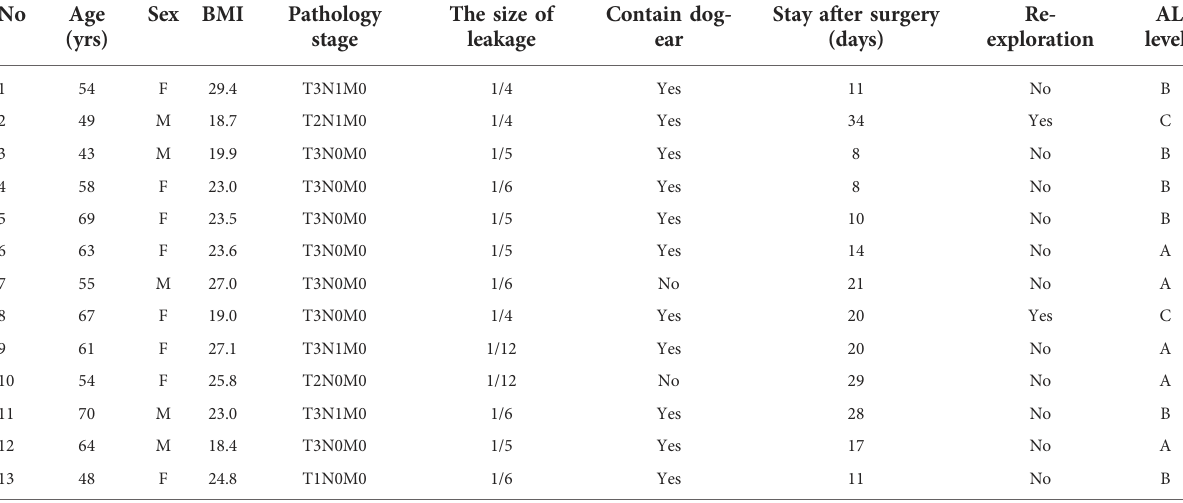
TABLE 4 Clinicopathological details of 13 AL patients in DST